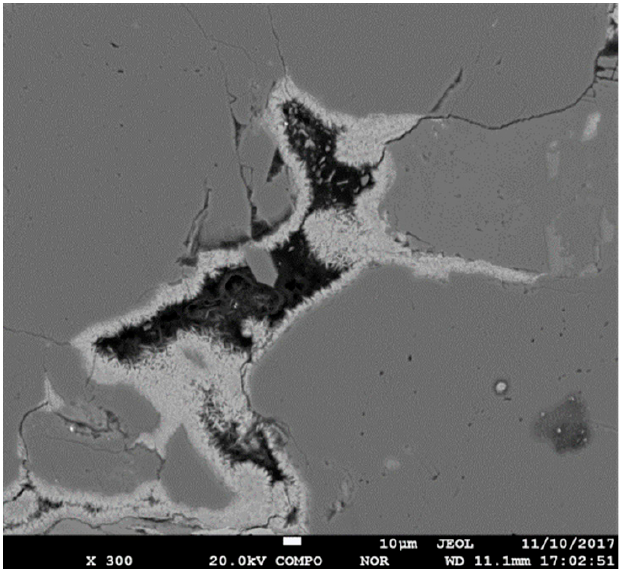
Figure 10. The silicon supersaturated in the pores formed autogenous and idiomorphic quartz (backscatter scanning electron microscopy).